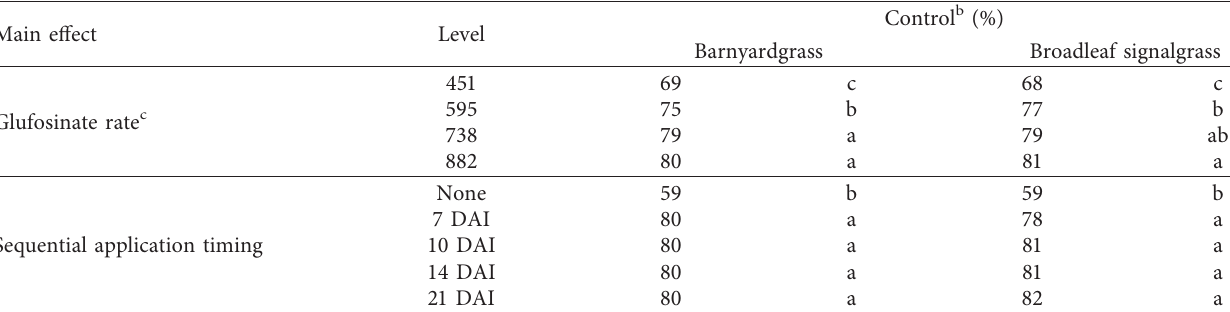
Table 7: Percent control of barnyardgrass and broadleaf signalgrass at harvest for the main effects of glufosinate rate and sequential application timing, averaged over the other factors in Fayetteville, AR, in 2015, 2016, and